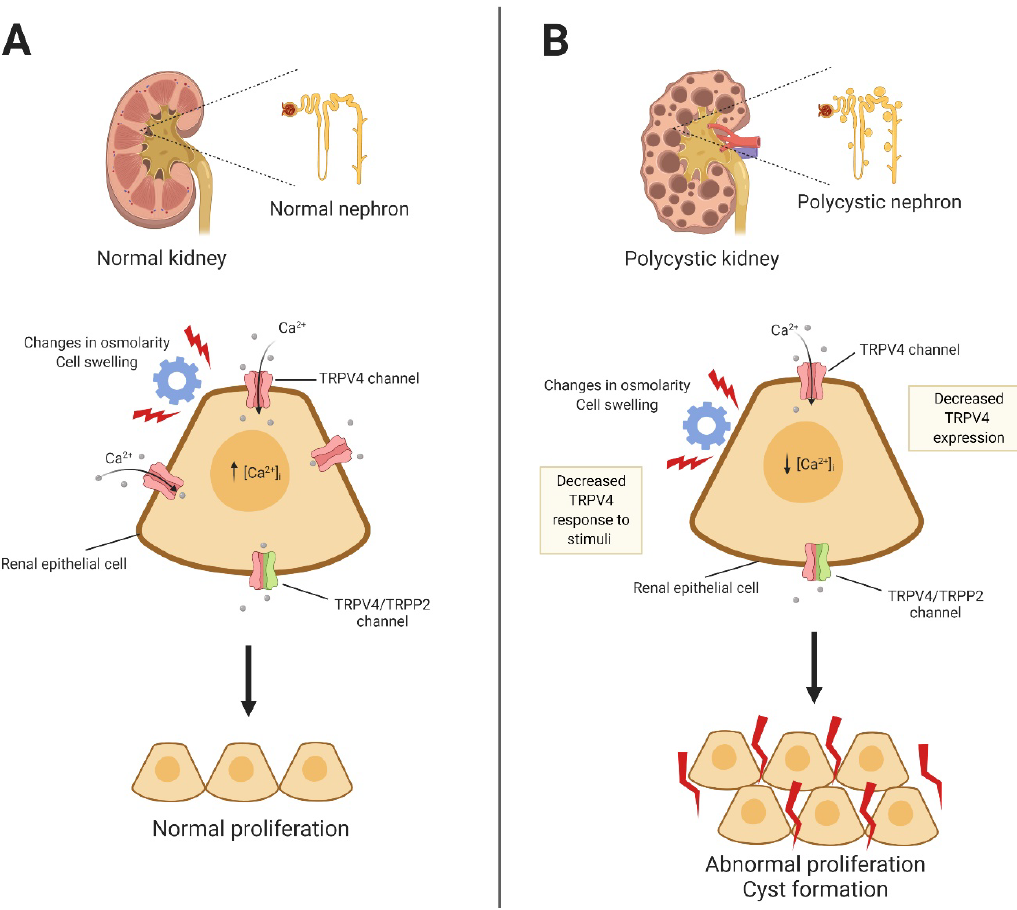
Figure 4. The activity of TRPV4 influences cyst growth and proliferation. ( A ) shows a normal kidney and nephron (top panel). The middle and lower panels show that when TRPV4 is adequately-expressed or activates normally, cell proliferation is kept under control. On the contrary, ( B ) shows that a polycystic kidney is full of fluid-filled structures which is a result of the lack of expression of correct function of TRPV4 (middle panel), resulting in abnormal proliferation and cyst formation (lower panel). Created with Biorender.com.